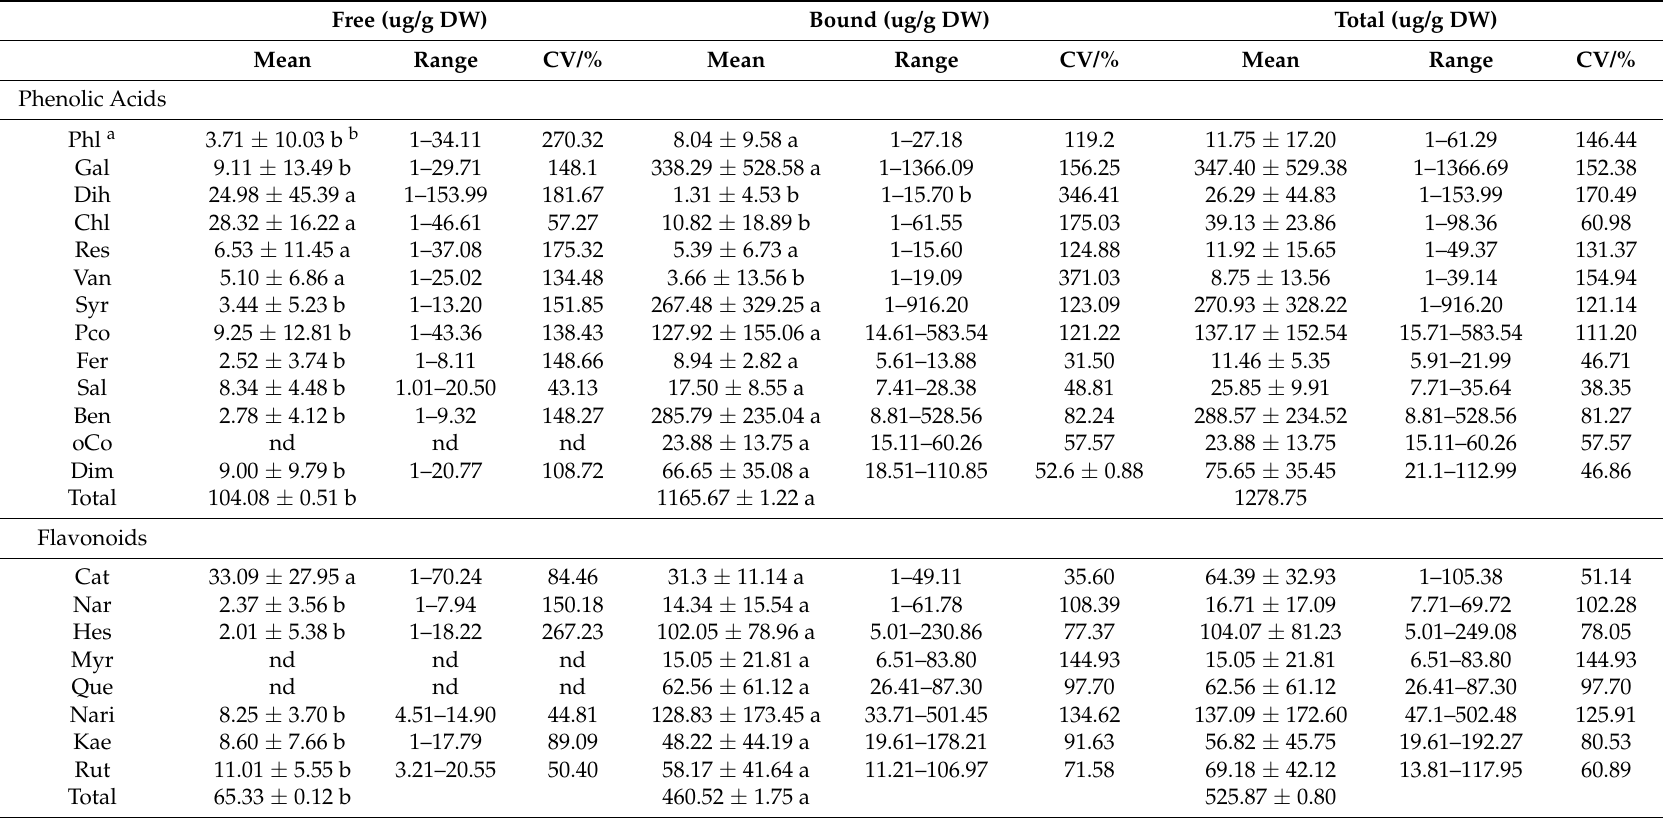
Table 3. Composition and content of phenolic acid and flavonoids in blue highland barley